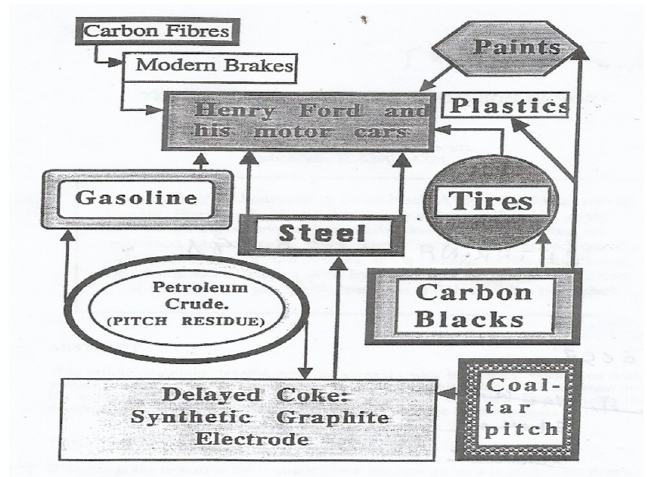
Figure 1. A schematic illustrating the interdependence of carbon industries.